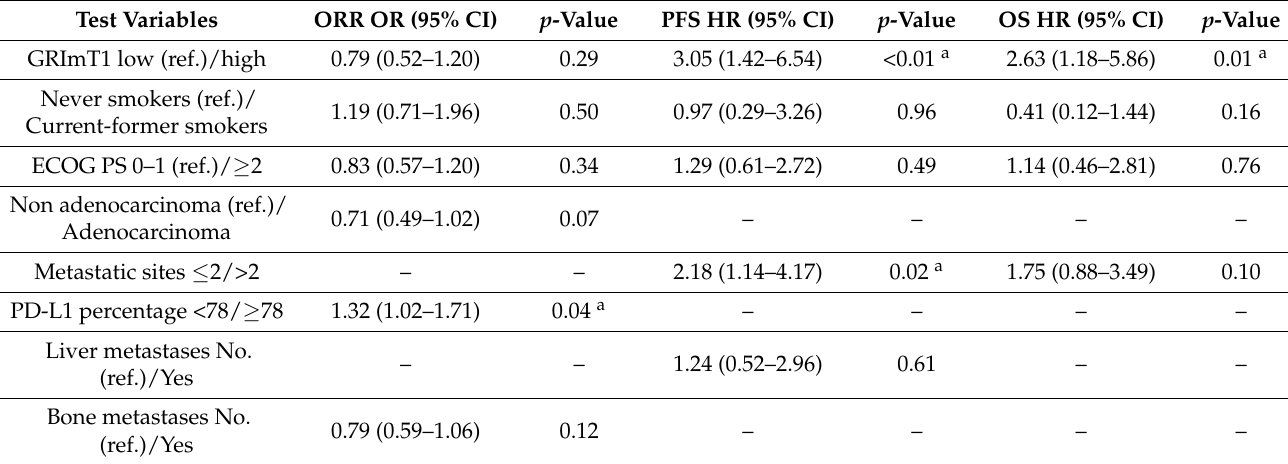
Table 2. Multivariable analyses for ORR, PFS and OS in pembrolizumab cohort considering GRImT1 as independent